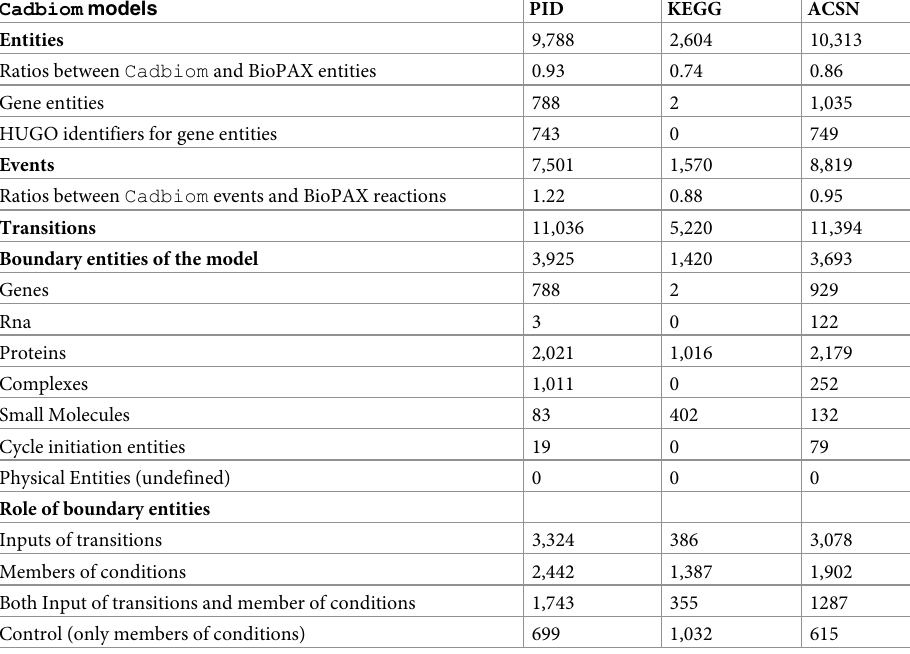
Table 2. Characteristics of the Cadbiom models obtained after the conversion of BioPAX sources into models with guarded transitions. The Cadbiom models are described by entities, events and transitions. They are compared to the numbers of entities and reactions in the BioPAX models. The boundary entities correspond to the peripherical entities of the model. They are described according to their type and their role in the cadbiom